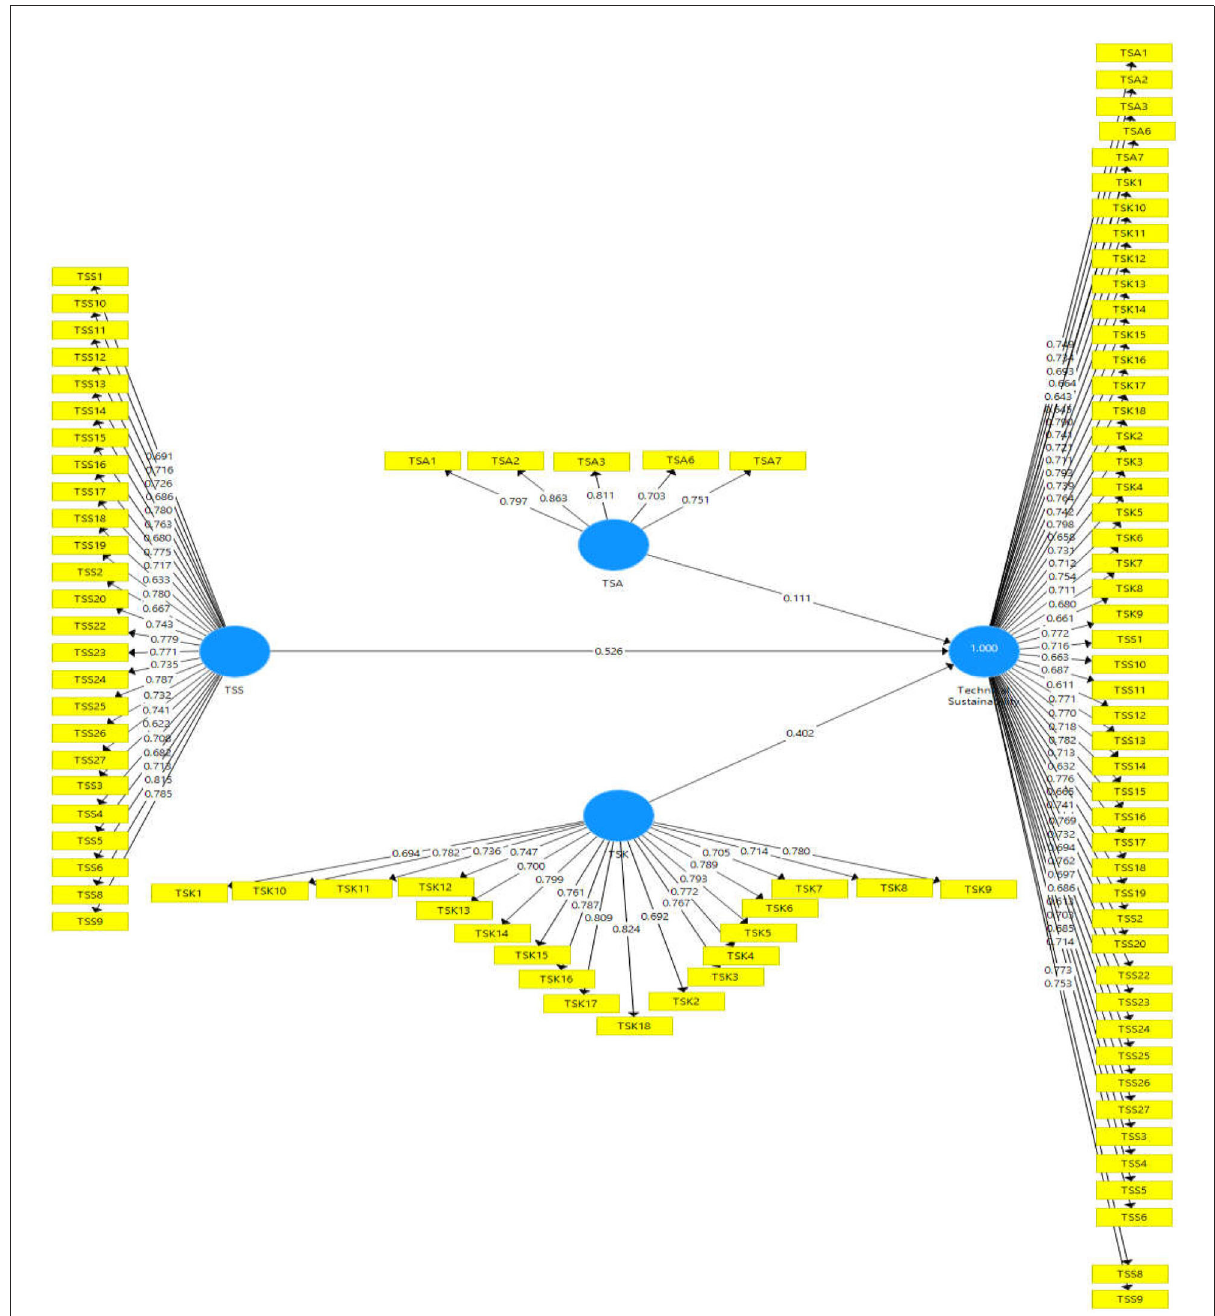
FIGURE1 Partial least squares (PLS) algorithm showing indicators’ loadings, paths’ coefficients, and coefficient of determination ( R 2 ).